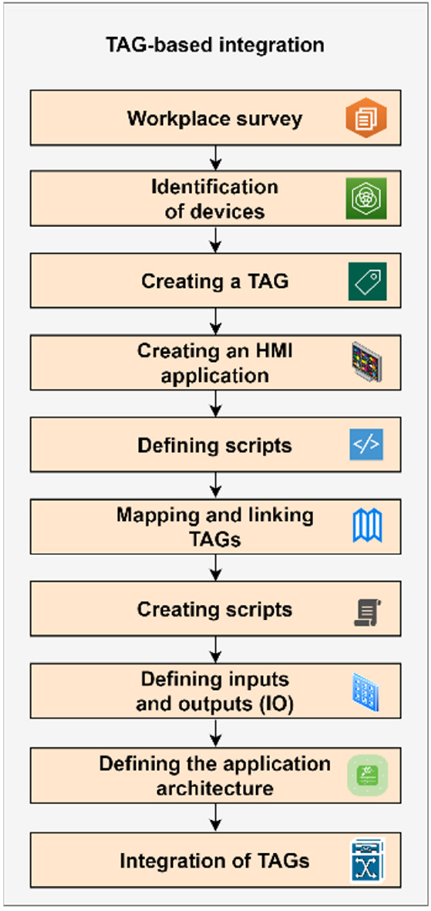
Figure 3. TAG-based integration model.